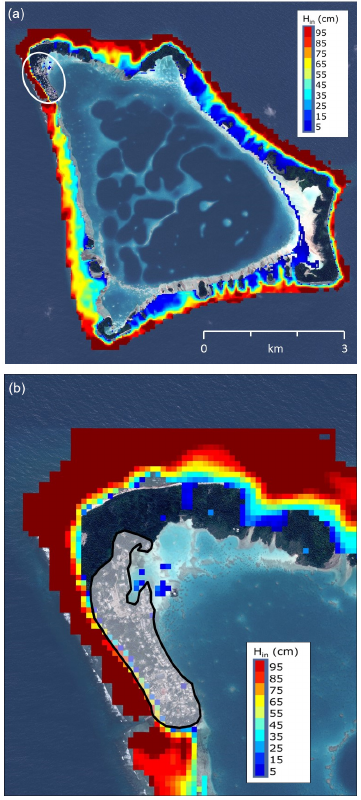
Figure 7. (a) Modelled maximum inundation for the atoll Atafu using the maximum estimates from all distant-earthquake source simulations. (b) Zoomed in image of the modelled tsunami-flood inundation depths (above m.s.l.) for the village on Atafu in the northwestern corner of the atoll (indicated by the semi-transparent grey area) from all distant-earthquake sources. For both images, the colour bar legend shows the maximum tsunami-flood inunda- tion depth (in centimetres above land, H in ). The uncoloured areas, where the underlying satellite image of the atoll and islets can be seen, are emergent land areas that remain dry during the modelled tsunami flooding events. The area of the village is circled in white (a) and outlined by the semi-transparent grey area (b) . The lagoon and fringing reef are not considered land in the model so have no colour, but because these areas are so shallow, on occasion one or two grid squares of colour might occur away from the known areas of land.